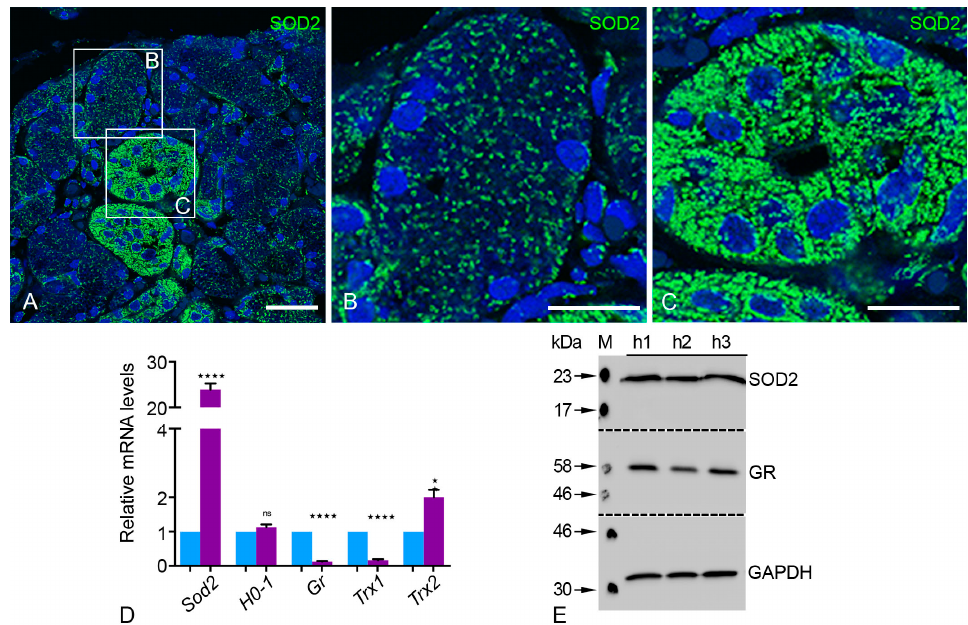
Figure 6. The antioxidant enzymes of different cell compartments in human parotid gland tissue. IF staining of SOD2 in the mitochondria showed the abundance in human parotid gland tissue ( A ) and enlarged sections of acini ( B ) and striated ducts ( C ). Bars represent: 100 µm ( A ); 50 µm ( B , C ). qRT-PCR analyses of mRNAs encoding for antioxidative enzymes of different cell compartments in human parotid glands (violet bars) compared to Gapdh (blue bars) as a housekeeping gene ( D ). For the following mRNAs the respective p -value is Sod2 **** p < 0.0001, Gr **** p < 0.0001, Trx1 **** p < 0.0001, Trx2 * p < 0.0097, ns: not significant. Western blot analysis for SOD2 and GR expression in human parotid gland tissue ( E ). GAPDH was used as a loading control.